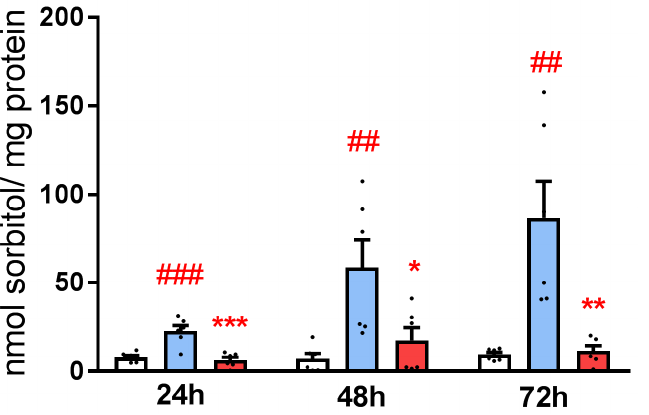
Figure 4. Effect of AKR1B1 inhibition on intracellular sorbitol accumulation. Intracellular sorbitol content was measured through fluorimetric detection (see Section 2.6) in HLE cells grown as described in Section 2.2, and exposed to different treatments for the indicated times; white bars: HLE cells incubated in MEM in the presence of 0.05% (v:v) DMSO; blue bars: cells incubated in MEM supple- mented with 0.05% DMSO and 75 mM D-glucose; red bars: cells incubated in MEM supplemented with 0.05% DMSO, 75 mM D-glucose, and 100 µ M sorbinil. All values are reported as the mean ± SEM of six independent measurements. Statistical analysis was performed using one ‐ way ANOVA with Tukey post hoc test. Significance was evaluated with respect to cells grown in normal conditions (##: p < 0.01 value; ###: p < 0.001) and with respect to cells exposed to 75 mM D ‐ glucose